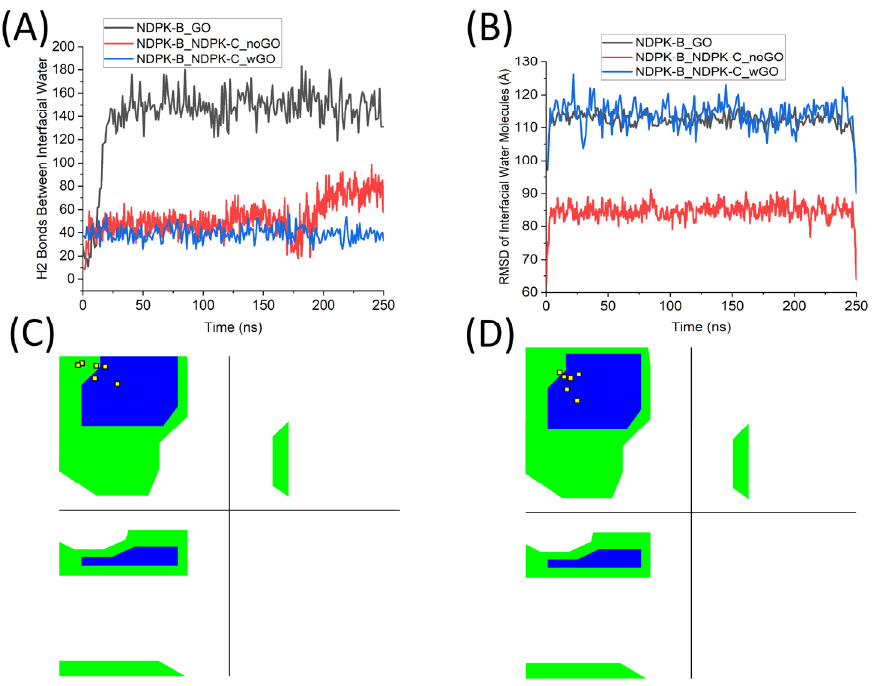
Figure 5. Regulation of interface between NDPK-B and NDPK-C by interfacial water molecules and Ramachandran plots: ( A ) Hydrogen bonds of the interfacial water molecules at the interface of NDPK-B and GO and between NPDK-B and NDPK-C in the presence and absence of GO; ( B ) RMSD of the interfacial water molecules between NDPK-B and GO, and between NDPK-B and NDPK-C in the presence and absence of GO; ( C , D ) Ramachandran plots for the six His118 residues in the absence and presence of GO.